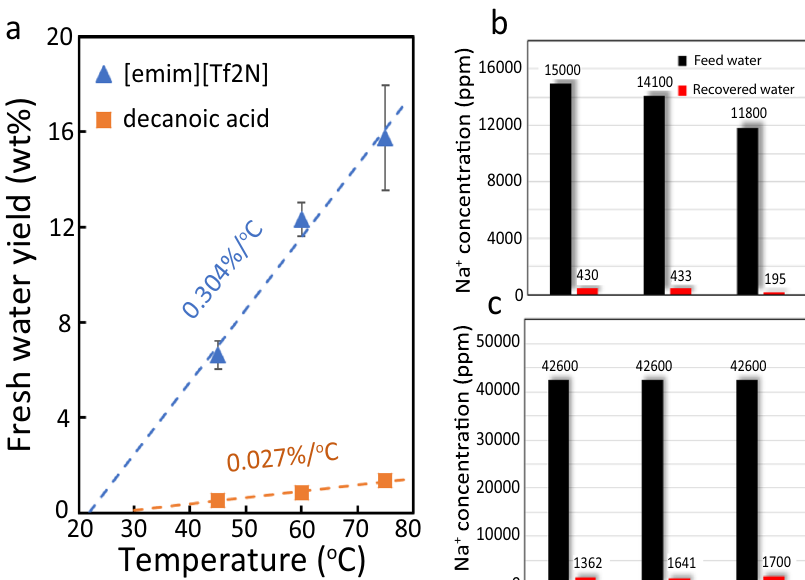
Fig. 3 Water yield and salt rejection observed in the experiment. a Water yield and temperature relationship of [emim][Tf 2 N] and decanoic acid. Error bar is the standard deviation of different tests for each condition. b Desalination of moderate salt content water (3.7 – 5.0 wt%). c Desalination of high salt content water (10.8 wt%). Each set of bars in b and c corresponds to one batch of